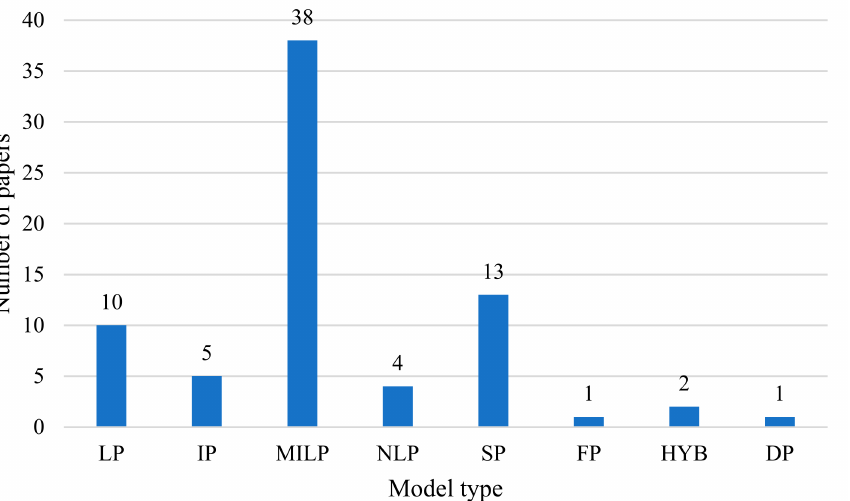
Figure 6. Number of papers according to model types (Note: LP: Linear programming, IP: Inte- ger programming, MILP: Mixed-integer linear programming, NLP: Nonlinear Programming, SP: Stochastic programming, FP: Fuzzy programming HYB: Hybrid, DP: Dynamic